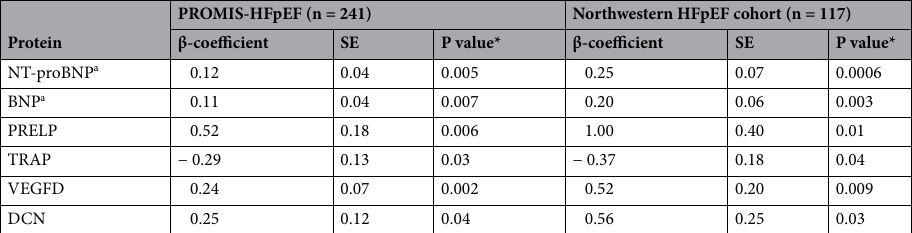
Table 4. Plasma proteins associated with disproportionate LA myopathy on multivariable linear regression in both PROMIS and Northwestern cohorts (validation). *False discovery rate-adjusted values. Adjusted for age, sex, and AF. a NT-proBNP and BNP were categorized as 1 distinct protein given BNP is a product of cleavage of NT-proBNP. BNP B-type natriuretic peptide, DCN decorin, NT-proBNP N-terminal pro-B-type natriuretic peptide, PRELP proline-arginine-rich end leucine-rich repeat protein, TRAP tartrate-resistant acid phosphatase, VEGFD vascular endothelial growth factor